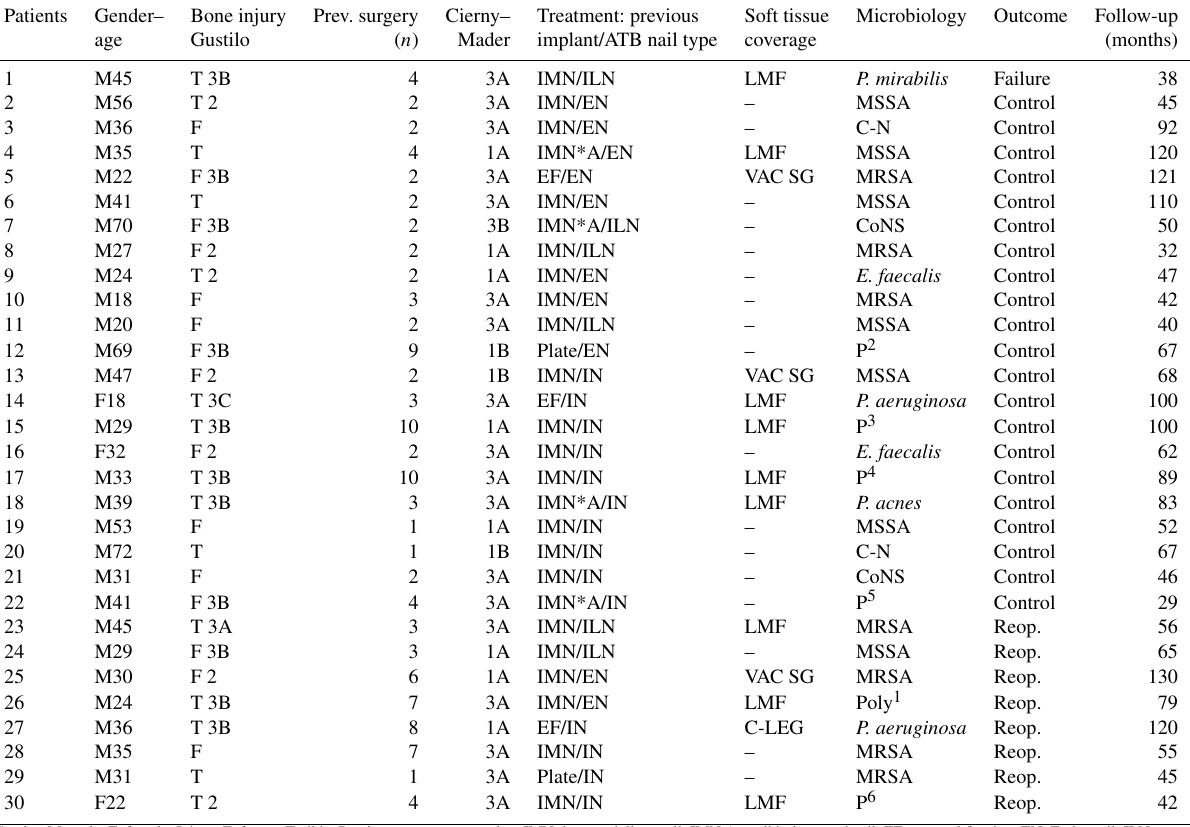
Table 1. Summary description of the preoperative characteristics, treatment and evolution of the patients in the series.